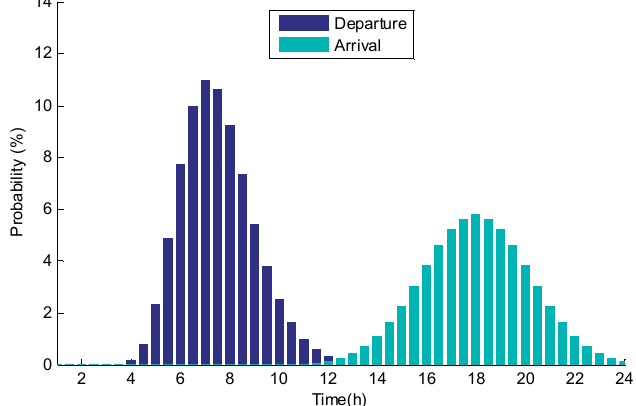
Figure 4. Probability of departure time from home and arrival time at home.